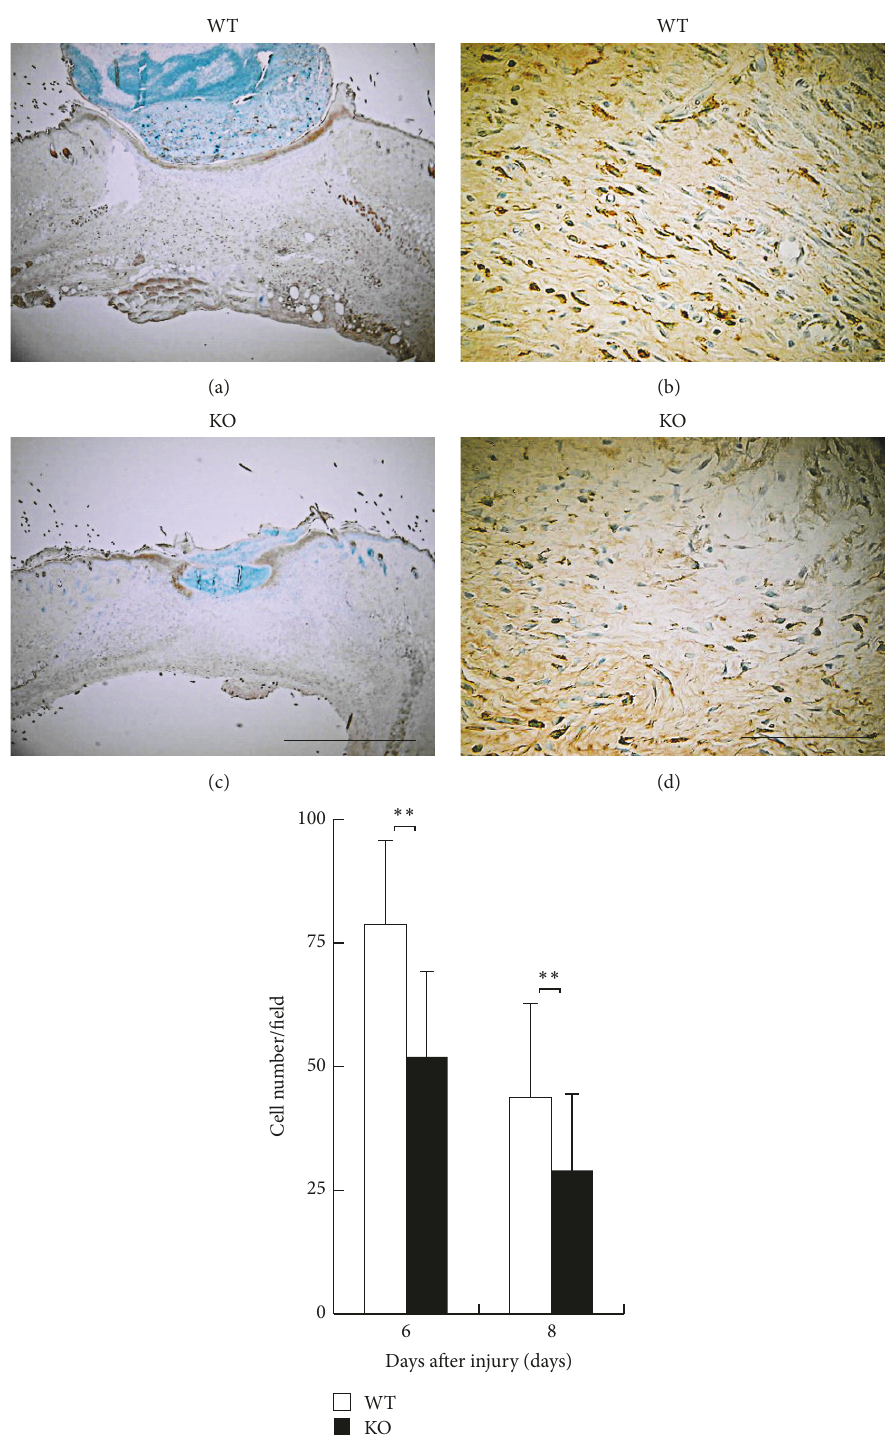
Figure 4: (a–d) Immunohistochemical observation of F4/80-labeled macrophages. Skin wound samples of wild type (WT) (a, b) and inducible nitric oxide synthase (iNOS-) knockout (KO) (c, d) mice indicate findings at day 6 after injury. (e) The numbers of F4/80-positive macrophages within a wound bed were enumerated on these five visual fields and analyzed macrophage recruitment. The infiltration of F4/80 labeled macrophages in KO mice was reduced with a statistical significance compared with WT mice at days 6 and 8 after injury. Open bars: WT, filled bars: iKO (days 6, 8: 𝑛 = 7 animals in each group). Mean ± standard deviation. ∗∗ 𝑝 < 0.01 ; bar 10 𝜇